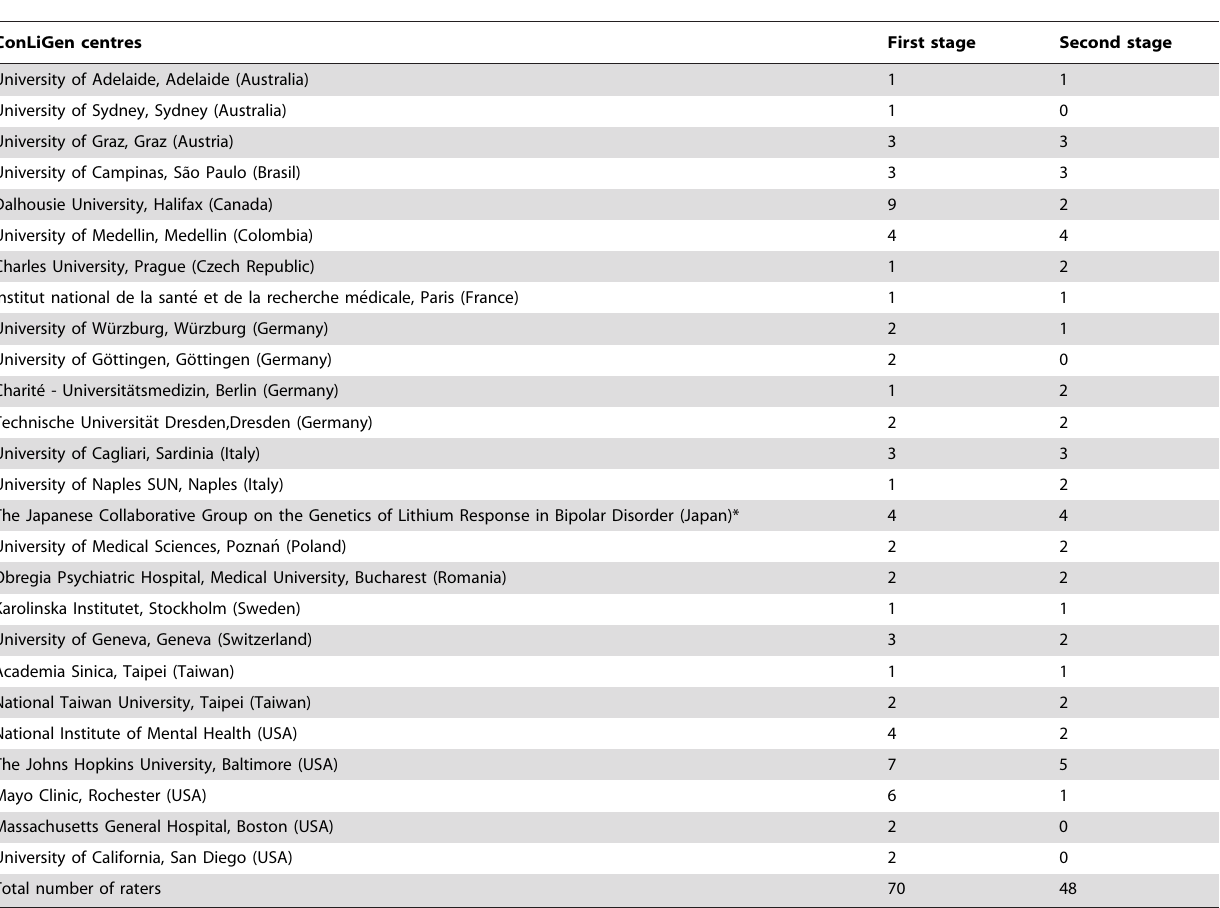
Table 1. Number of raters from the Consortium on Lithium Genetics (ConLiGen) centres participating in the two-stage case- vignette rating procedure for inter-rater reliability and